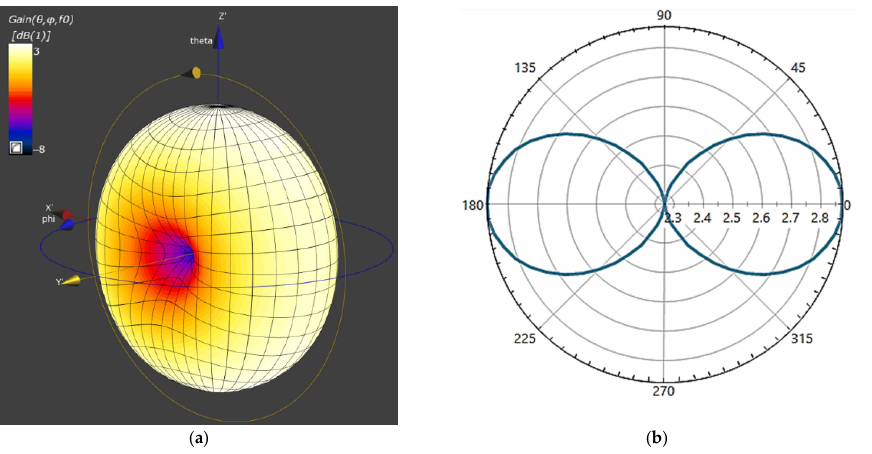
Figure 2. Investigated antenna far-field pattern: ( a ) 3D and ( b ) 2D in antenna plane.